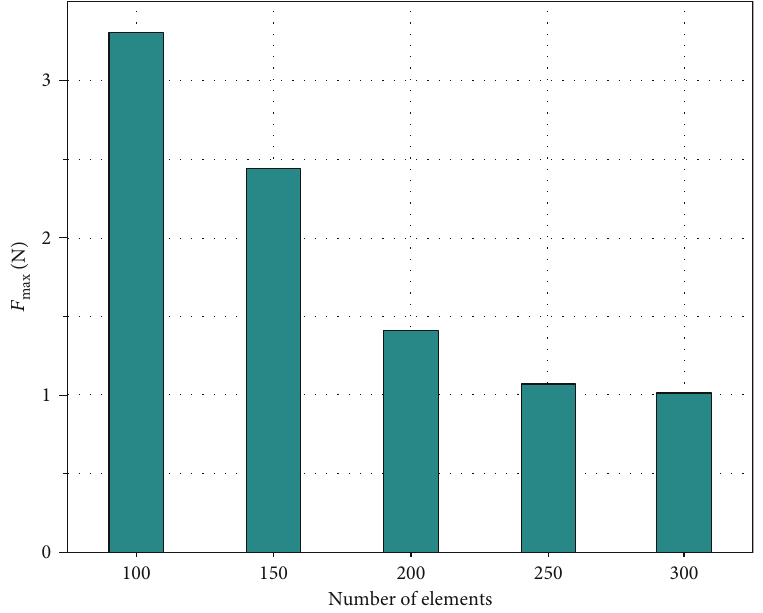
Figure 9: Maximum contact force of the